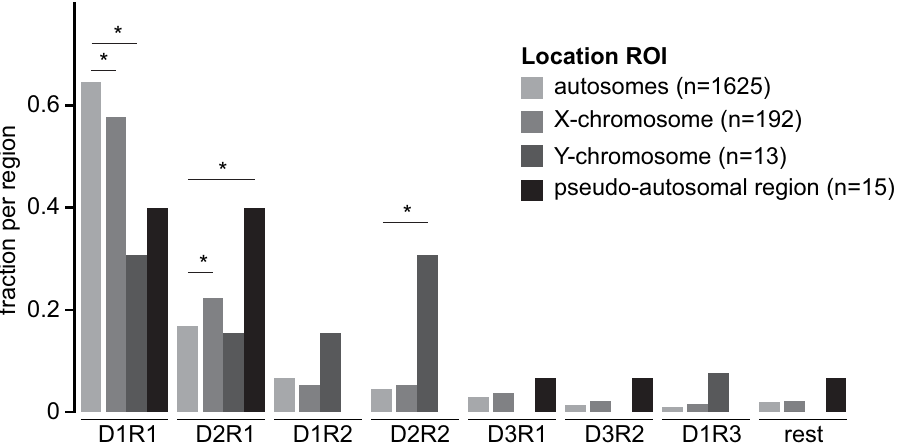
Fig 8. Recombinase configurations at sex-chromosomes. Barplot of fraction of RAD51 and DMC1 configurations of ROIs present on the X chromosome, Y chromosome, PAR and the autosomes of late-zygotene and early pachytene nuclei. p-values can be found in S2 Table. n indicates the number of